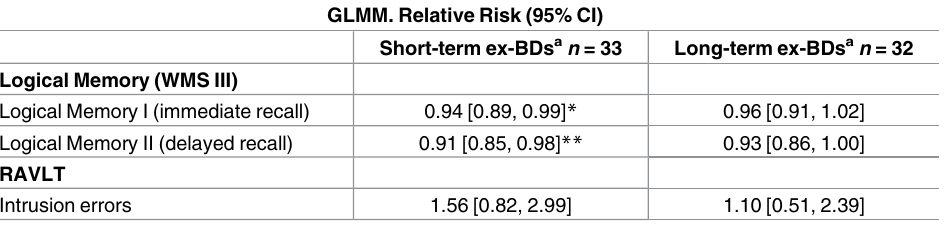
Table 5. Generalized linear mixed models for neuropsychological difficulties in participants who abandoned the BD